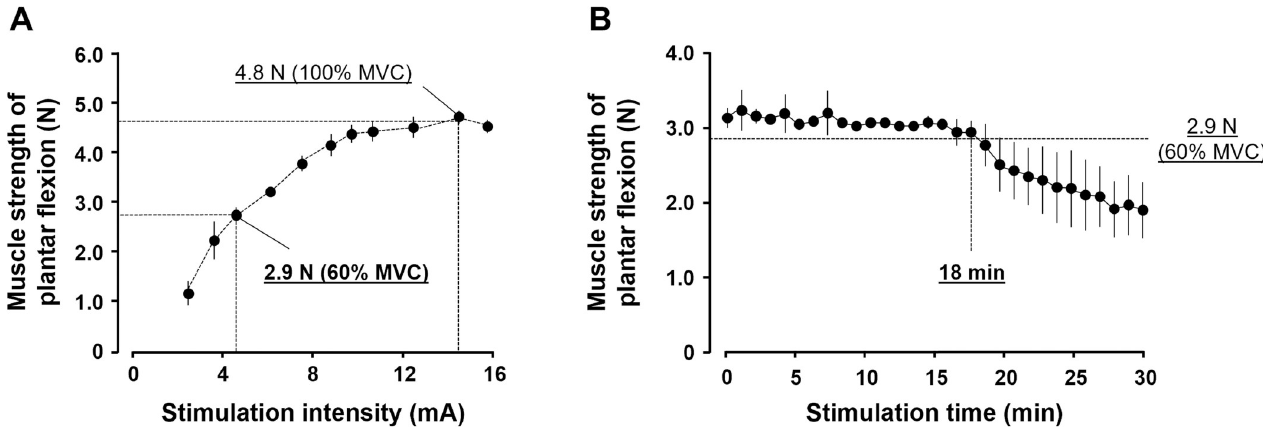
Fig 1. Results of preliminary experiments to determine the stimulation intensity and time. (A) Preliminary experiment to determine the stimulus intensity. The 100% and 60% maximal voluntary contraction (MVCs) were 4.8 N and 2.9 N, respectively. The results indicated that 4.7 mA corresponded to the 60% MVC. (B) Preliminary experiment to determine the stimulus time. This experiment observed the changes in the muscle strength of plantar flexion. The results showed that the strength decreased to < 2.9 N at 18 min after the electrical